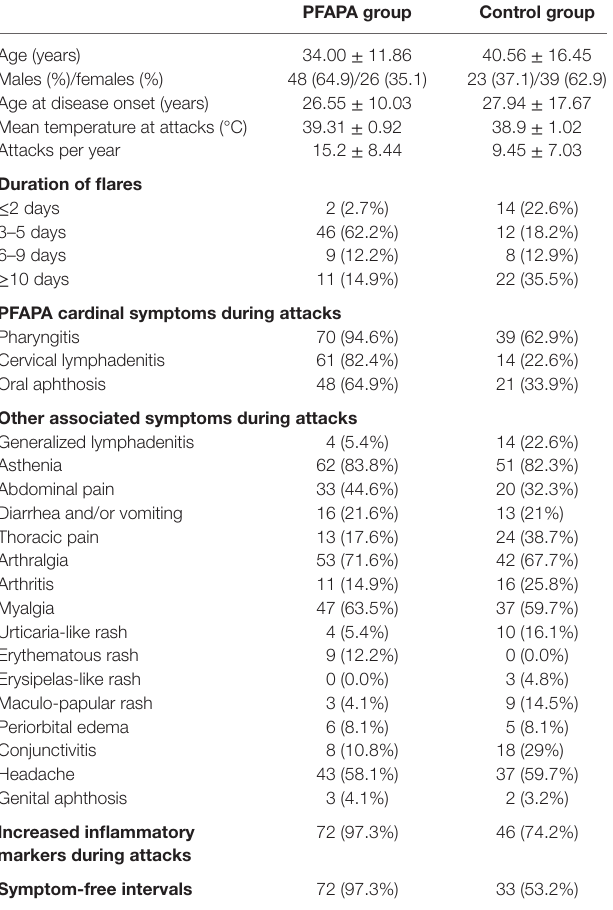
TaBle 1 | Demographic and clinical features of patients diagnosed with periodic fever, aphthous stomatitis, pharyngitis, and cervical adenitis (PFAPA) syndrome (PFAPA group) and patients with fever of unknown origin (control